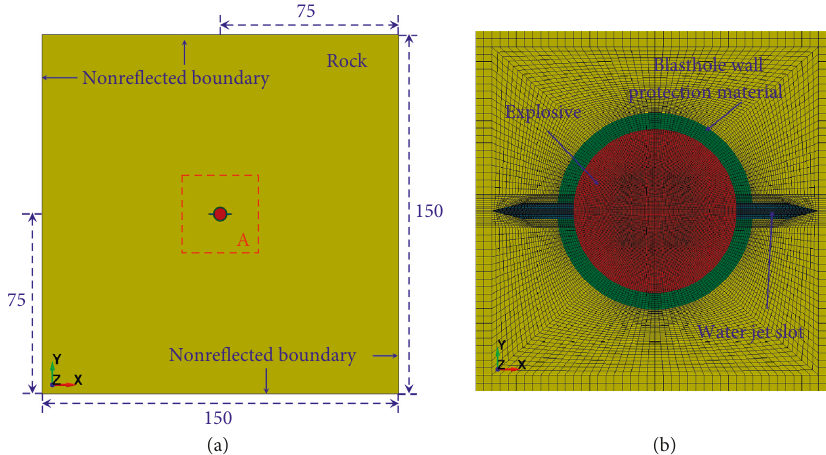
Figure 8: Numerical simulation model: (a) #3 simulation model; (b) enlargement of part Table 3: Parameters of rock.